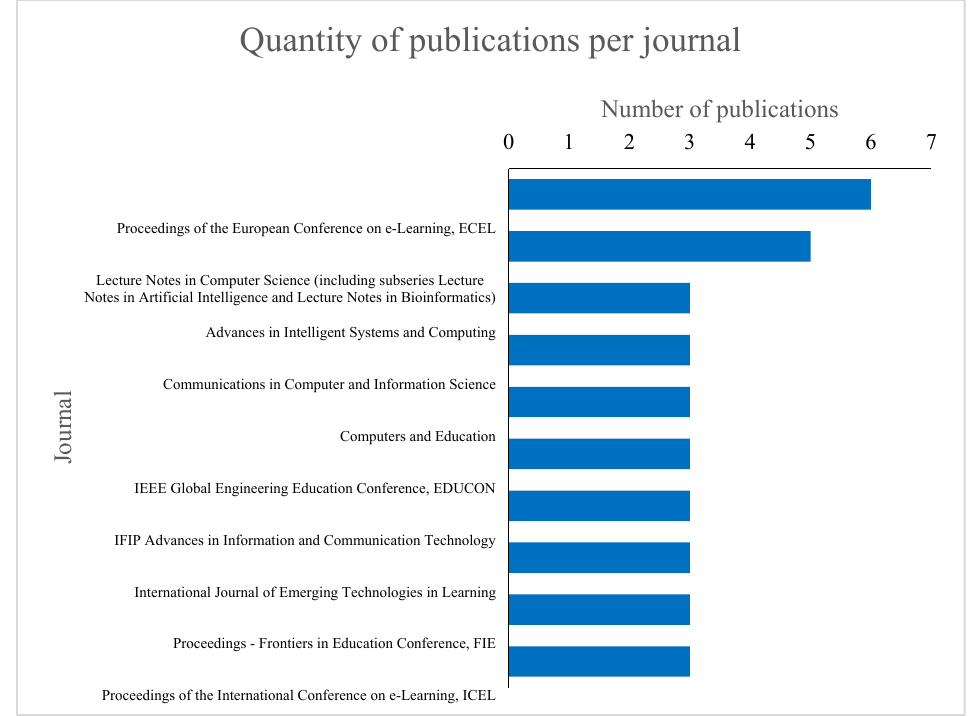
Figure 3. Number of publications per journal. Own elaboration from SCOPUS data.